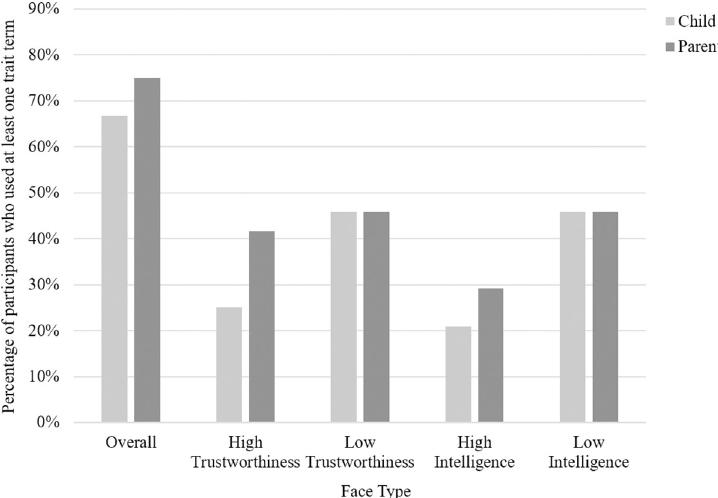
Fig 6. Study 2: Bar graph showing the percentage of parents (N = 24) and children (N = 24) who used at least one trait term during conversation, shown overall and separated by face type.